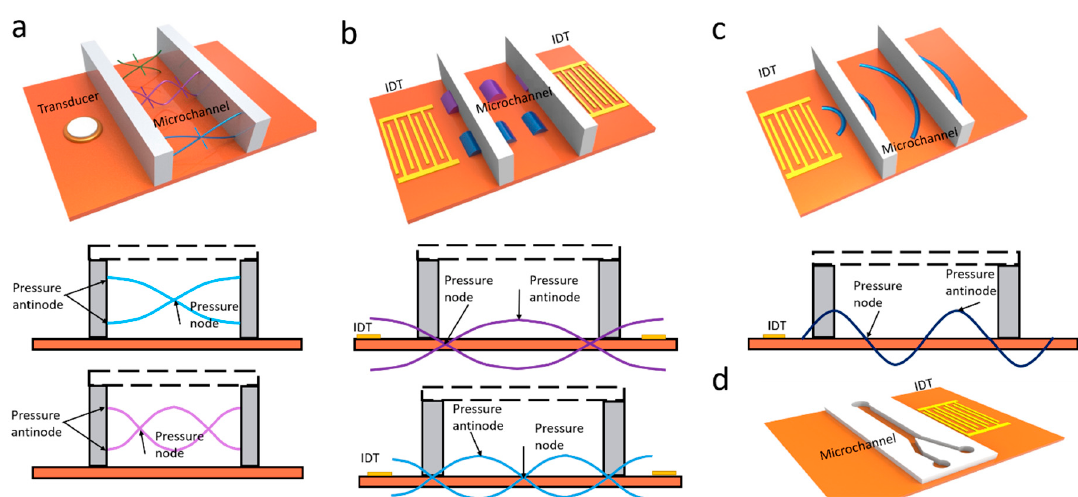
Figure 1. ( a ) Schematic illustration of propagation of bulk acoustic waves (BAWs) in a microchannel; ( b ) Schematic illustration of propagation of standing surface acoustic waves (SSAWs) in a microchannel; ( c ) Schematic illustration of propagation of traveling surface acoustic waves (TSAWs) in a microchannel; ( d ) Schematic illustration of an acoustic microfluidic device. IDT—interdigitated transducer.